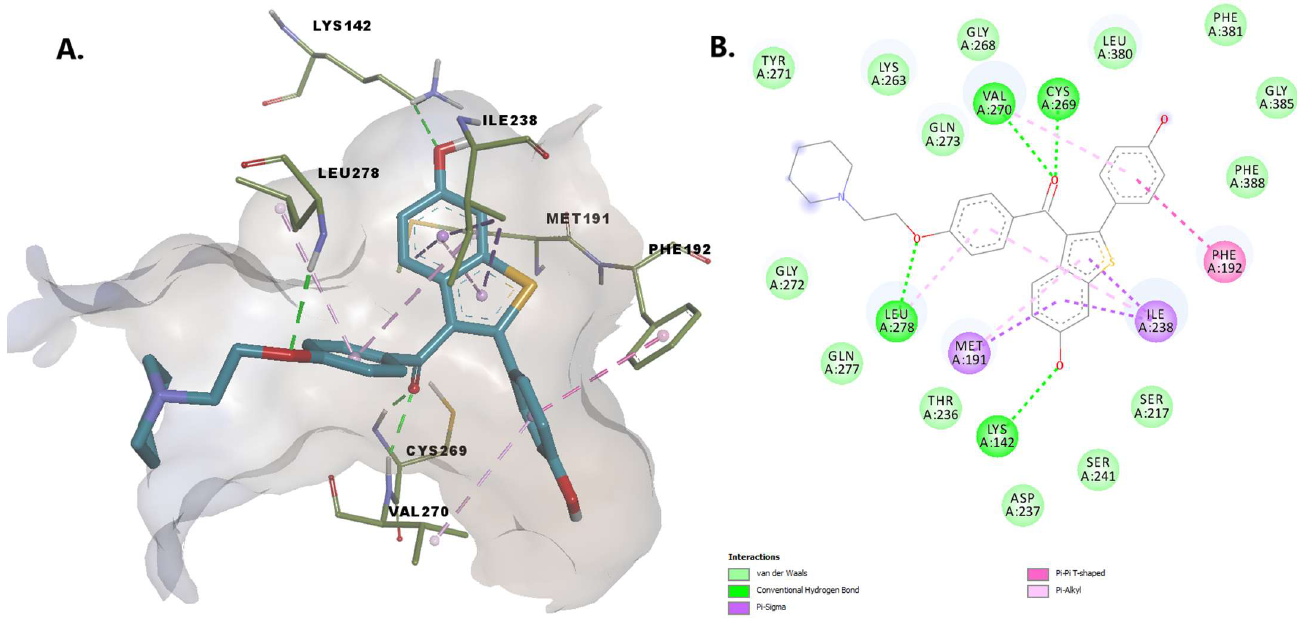
Figure 9. ( A ) 3D binding conformation of raloxifene into FAAH binding site; ( B ) 2D diagram of protein-ligand interactions between FAAH and raloxifene.